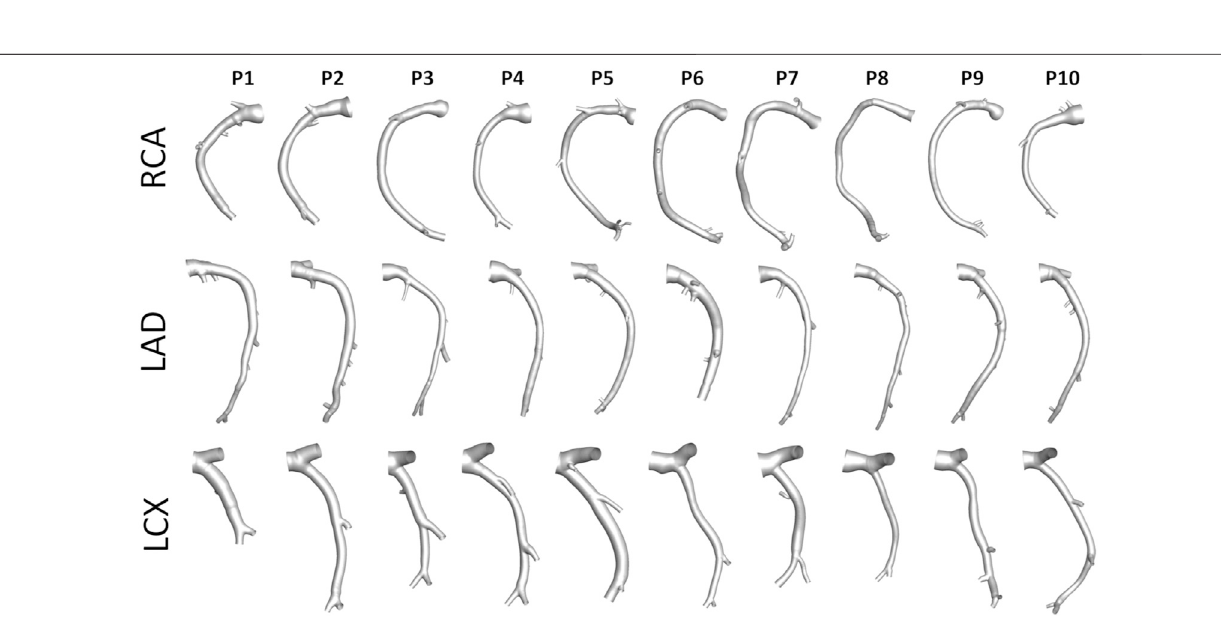
Frontiers in Bioengineering and Biotechnology |